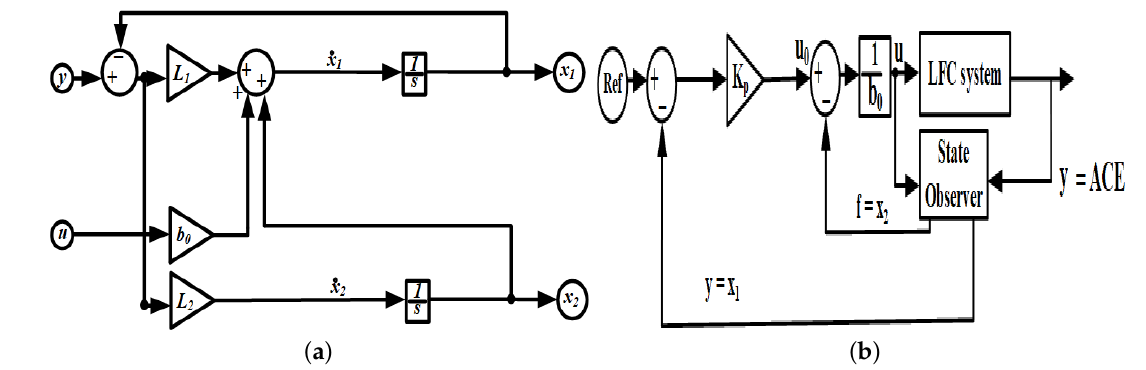
Figure 3. Proposed 1D-ADRC with ESO for the present HES. ( a ) ESO block diagram. ( b ) 1D-ADRC with ESO)